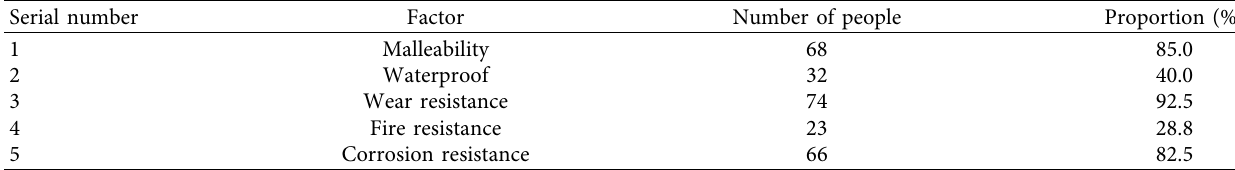
Table 2: Questionnaire survey results affecting the quality of sports equipment.